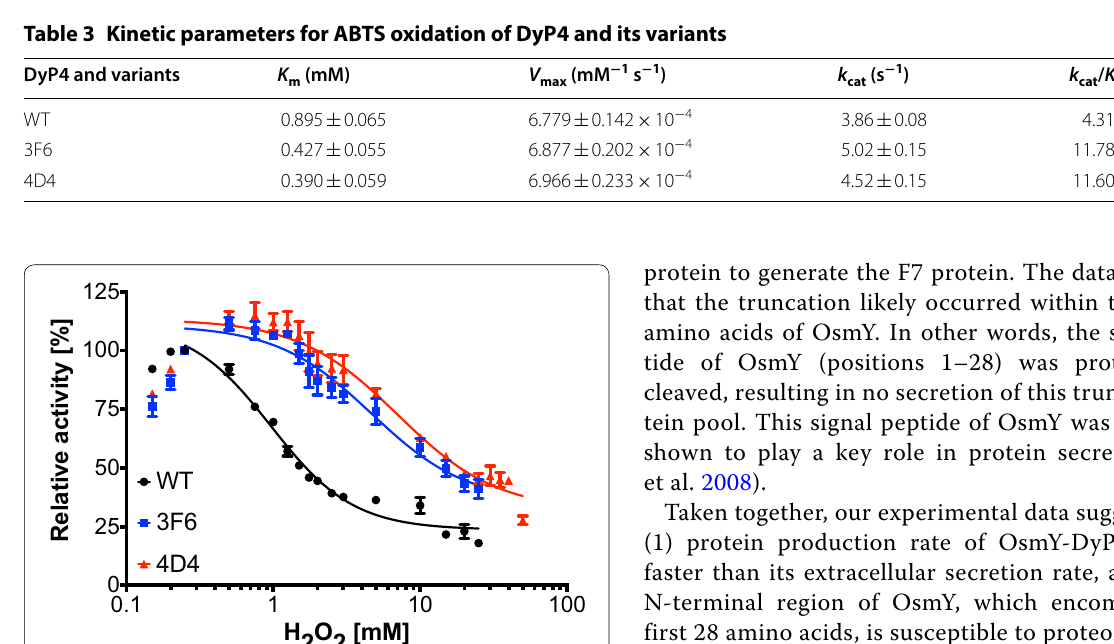
Table 4 H O tolerance data of DyP4 and its variants were 2 2 fitted to an inhibitory dose–response curve with a variable slope (4 parameters), using GraphPad